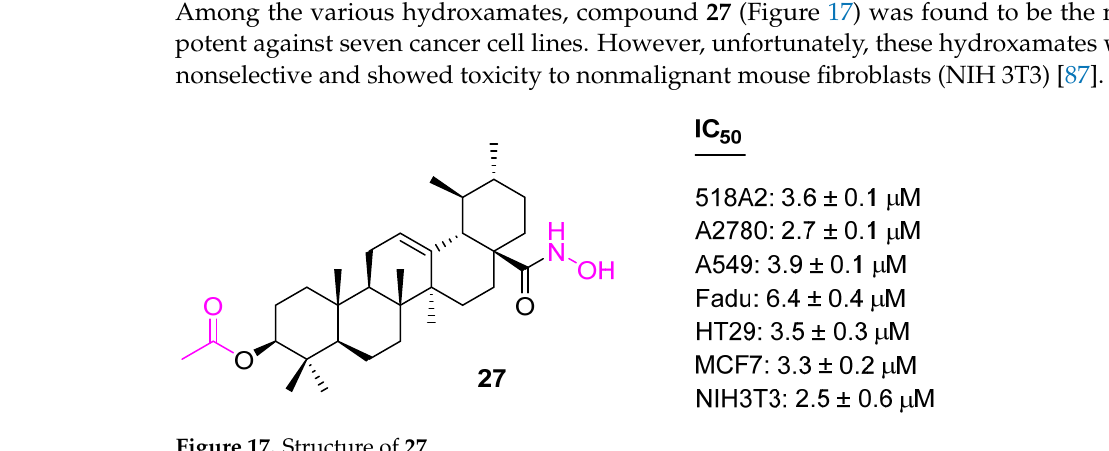
Figure 17. Structure of 27